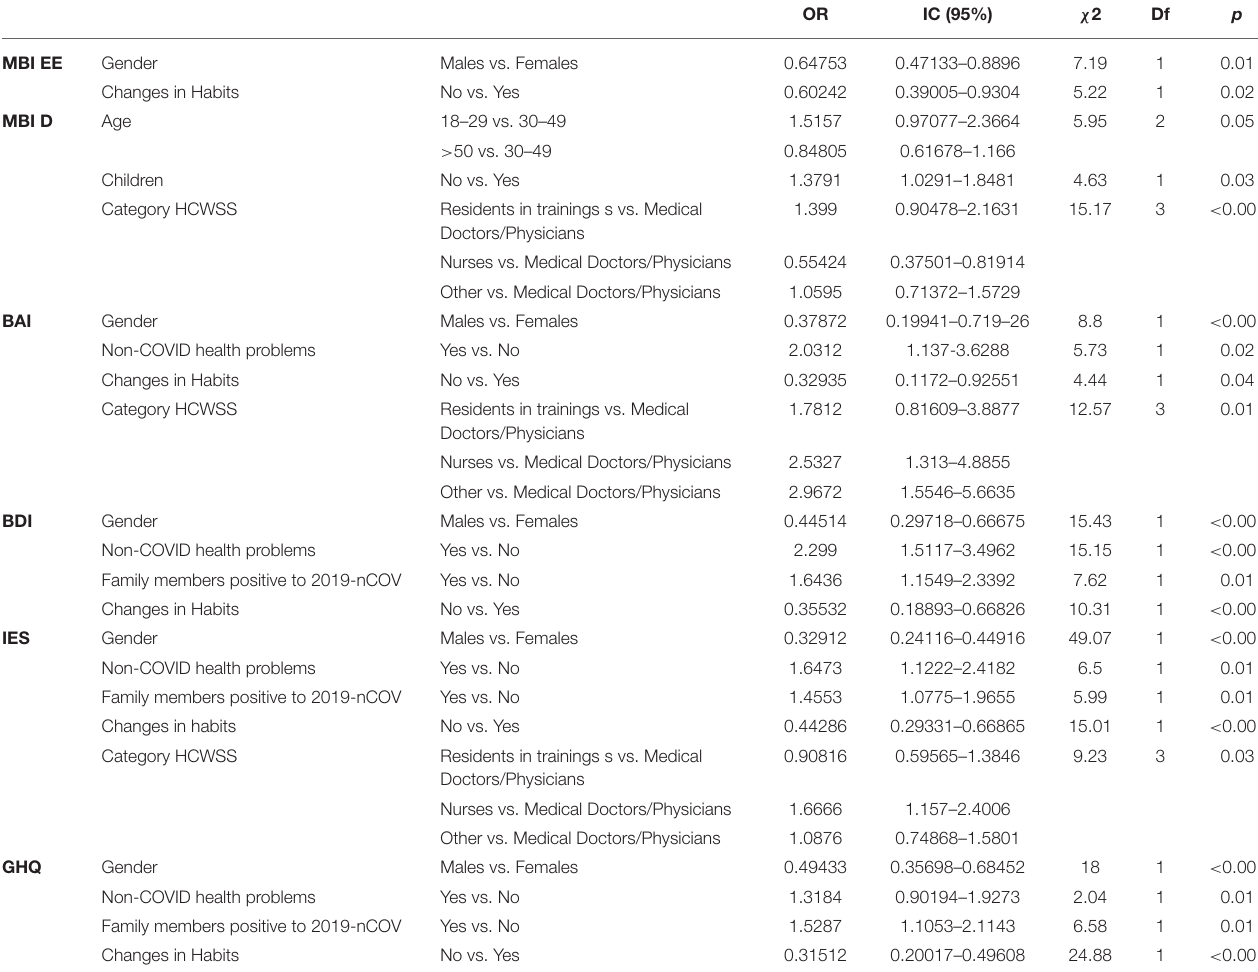
TABLE 6 | Results of the univariate